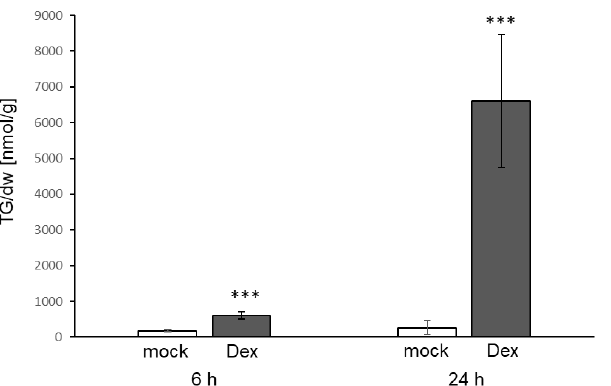
Figure 7. Accumulation of TGs in leaves of Dex::avrRPM1 plants 6 h and 24 h after spraying of leaves with dexamethasone to induce expression of AVRRPMI (Dex, dark grey bars) or mock (white bars). Shown is the mean of at least four biological replicates ± sd of the sum of TGs [nmol/g dry weight] with 52 and 54 acyl carbon atoms and one to nine double bonds. Asterisks indicate significant differences between the dexamethasone treated samples and the corresponding mock treated sample (*** p < 0.001).